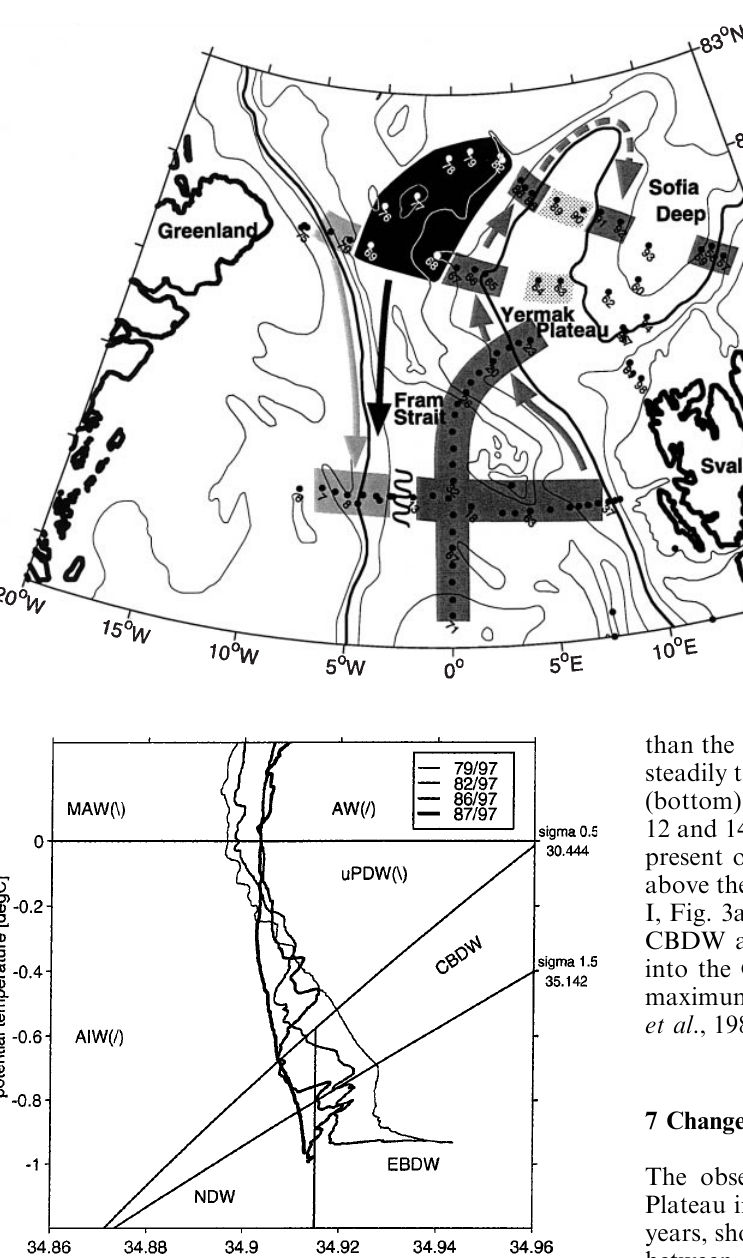
Fig. 14. Q -S diagram showing the interleaving and mixing of the NDW with the Arctic Ocean deep waters north of the